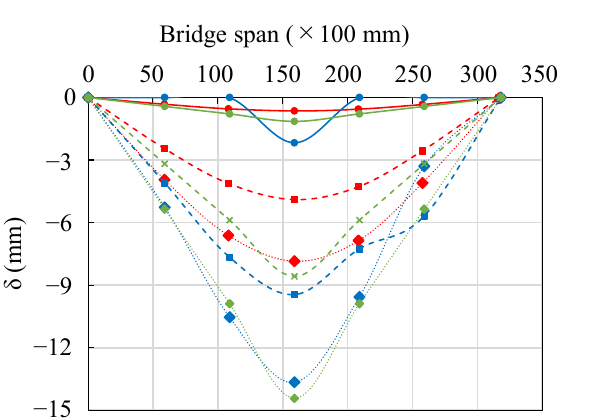
Figure 6. Deflection angles calculated from transducer and image processing measurements and FEA FEA at ( a ) R1. ( b ) R2. ( c ) R3. ( d ) R4. ( e ) L1. ( f ) L2. at ( a ) R1. ( b ) R2. ( c ) R3. ( d ) R4. ( e ) L1. ( f ) L2.